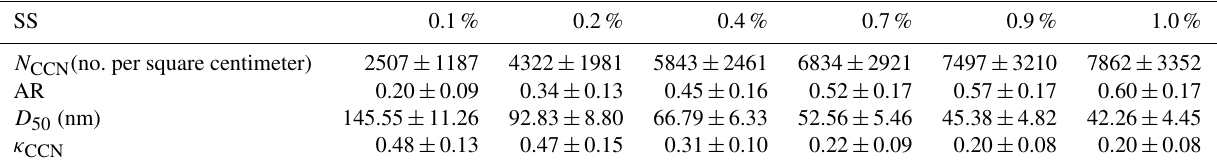
Table 3. The average and standard deviation values (mean ± SD) of N CCN , AR, D 50 , and κ CCN at 0.1%, 0.2%, 0.4%, 0.7%, 0.9%, and 1.0%SS during the campaign. SS 0.1% 0.2% N CCN (no. per square